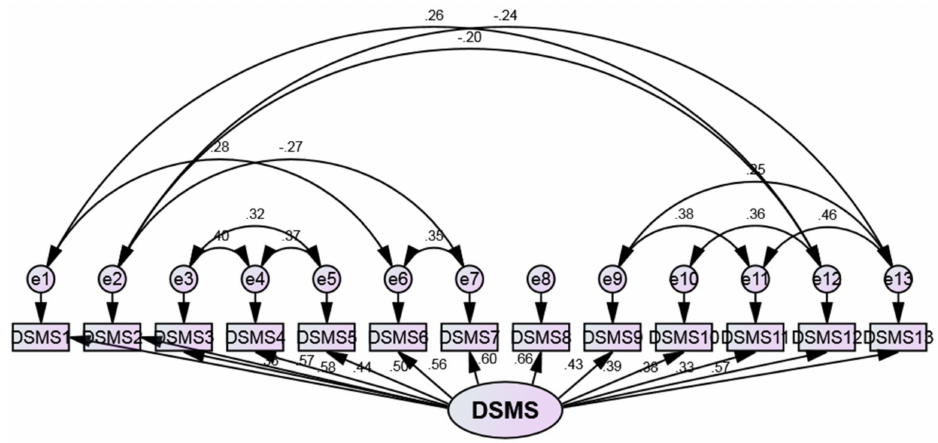
Figure 2. Confirmatory factor analysis. The analysis was conducted using AMOS